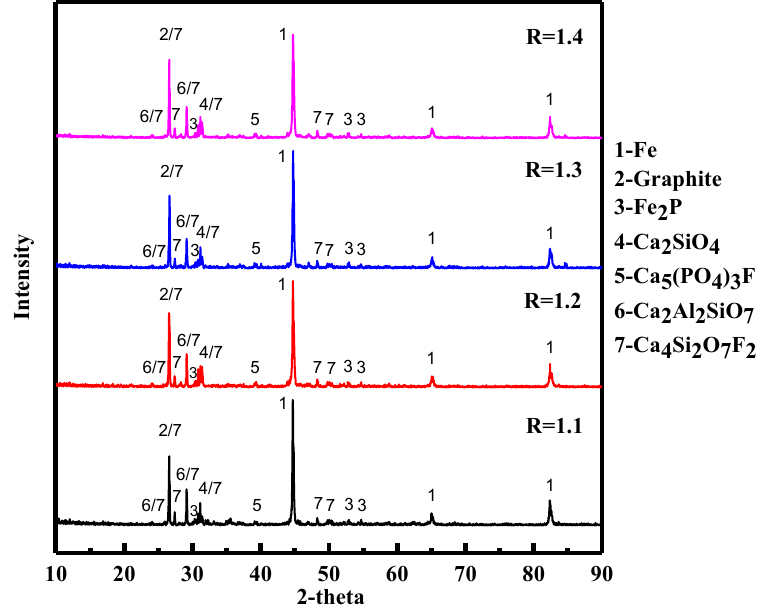
Figure 7. XRD spectra of reduced pellets at different basicity.